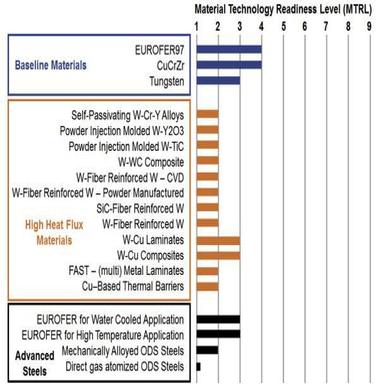
MTRL of baseline materials and advanced steels and high heat flux materials.